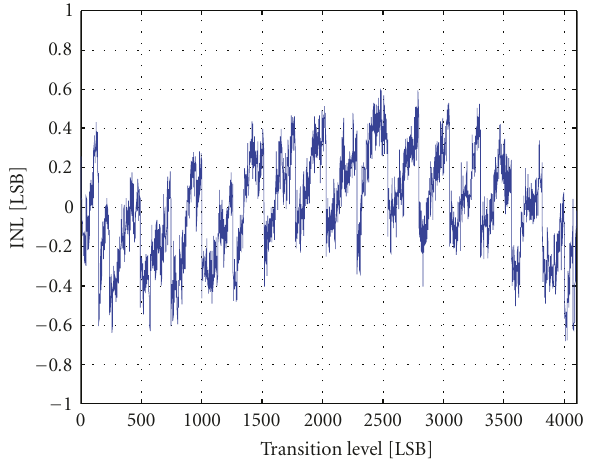
Figure 4: Exemplary measured INL from a 12bit commercial